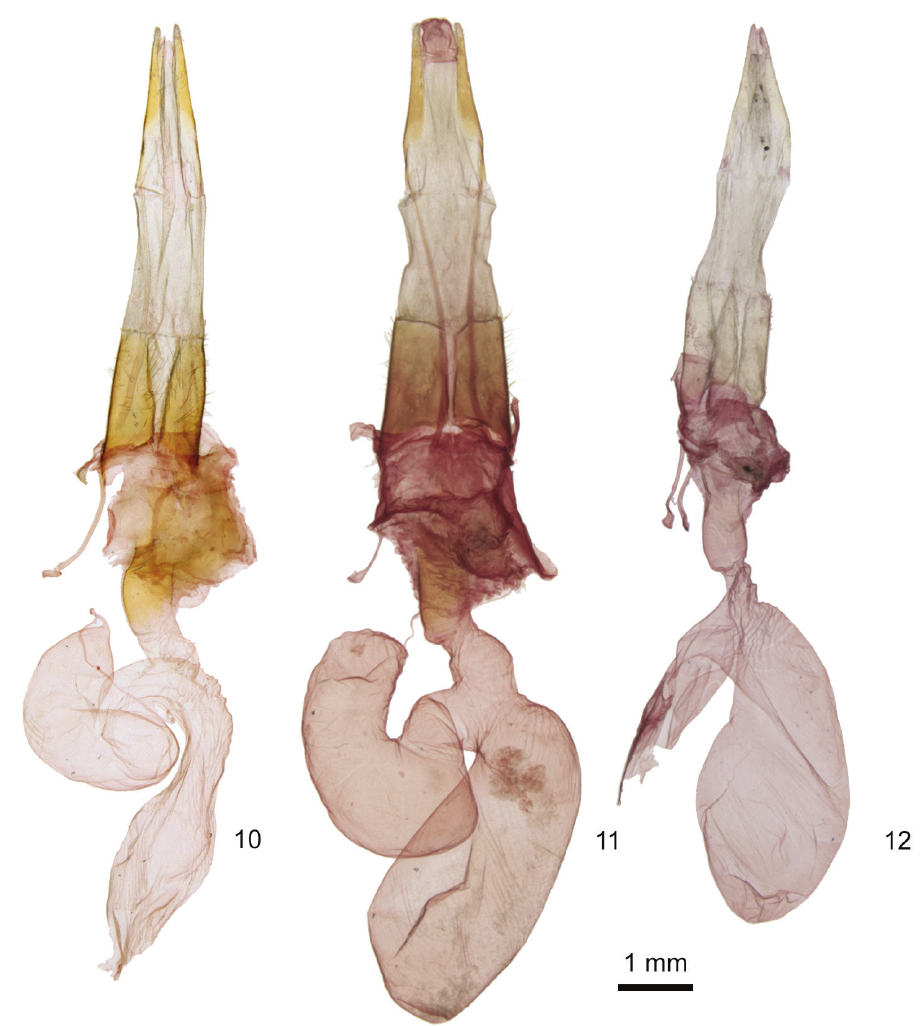
Structurally, males of R. durango have the largest and most complex distal clasper in the genus, with a blunt curved ventral process that extends ventral to the valve and a molar like mesial process that projects over the distal valve. By comparison, the distal clasper of other species is much smaller ( R. pattersoni ) or lacks the broad mesial process ( R. petersoni ). Females of R. durango can be identified by the shape of the concave ventrolateral sternite A7 (Figure 14). The concavity is similar to that of R. pattersoni in that it lacks a transverse sulcus, but the lateral edge of R. durango is rounded rather than quadrate. The lateral edge is shaped like the pinna of a human